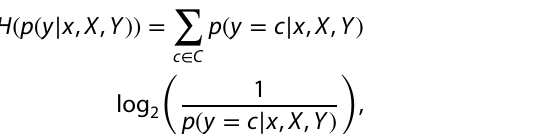
Fig. 7 Model uncertainty H for dataset 2 with the complicated defect